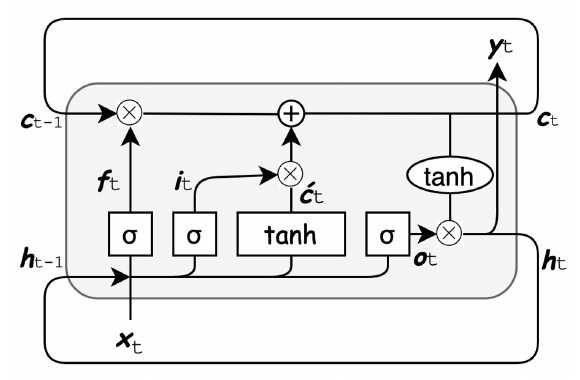
Figure 2. Long Short-Term Memory